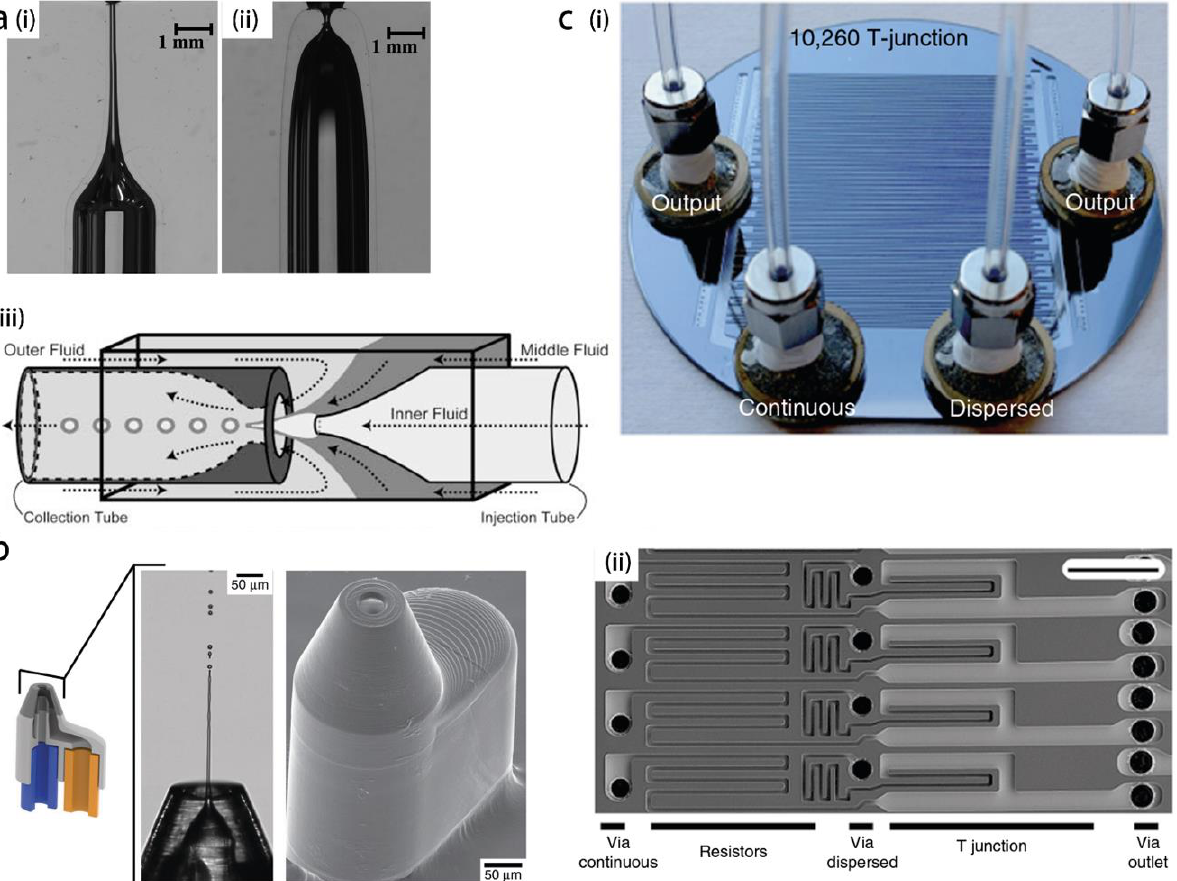
Figure 10. Recently developed strategy for micro-device fabrication. ( a ) A comparison between pulled capillary ( i ) and flame-shaped capillary ( ii ), and the application of flame-shaped capillary to be assembled with other capillaries for core-shell droplet generation ( iii ). Reproduced from [125,126], copyright 2005, AAAS and copyright 2018, Elsevier. ( b ) 3D micro-nozzle printed with direct laser writing, that can easily be assembled with feeding capillaries to form submicron jet at speed exceeding 160 m/s. Reproduced from [129], copyright 2020, Springer Nature. ( c ) Silicon-glass micro-device with 10,260 parallelized channels for micro-droplet generation, the whole view of the device ( i ) and zoom on the channels ( ii ), feeding channels for fluids are etched on the back side of the silicon wafer, opposed to the droplet generation channels. Reproduced from [100], copyright 2018, Springer Nature.